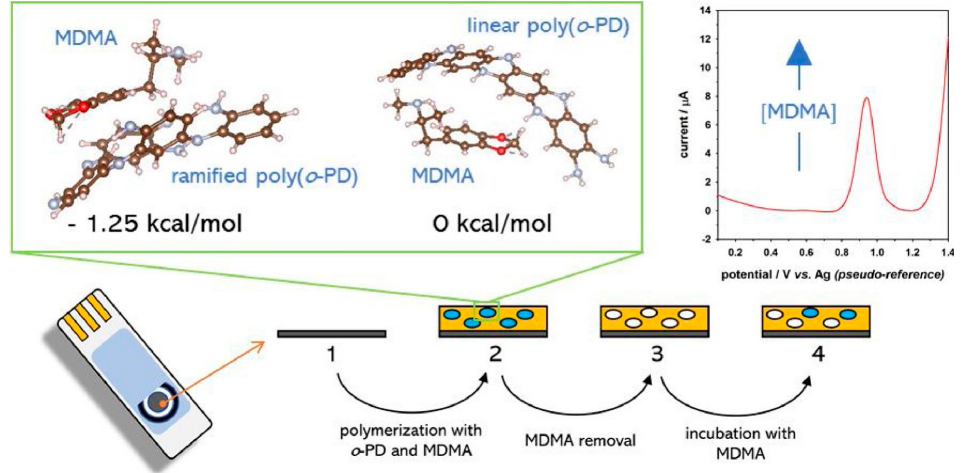
Figure 3. Schema of ecstasy-imprinted polymer on a screen-printed electrode and direct electrochemical detection of ecstasy (MDMA: 3,4-methylenedioxymethamphetamine) binding. Reprinted by permission from [68].